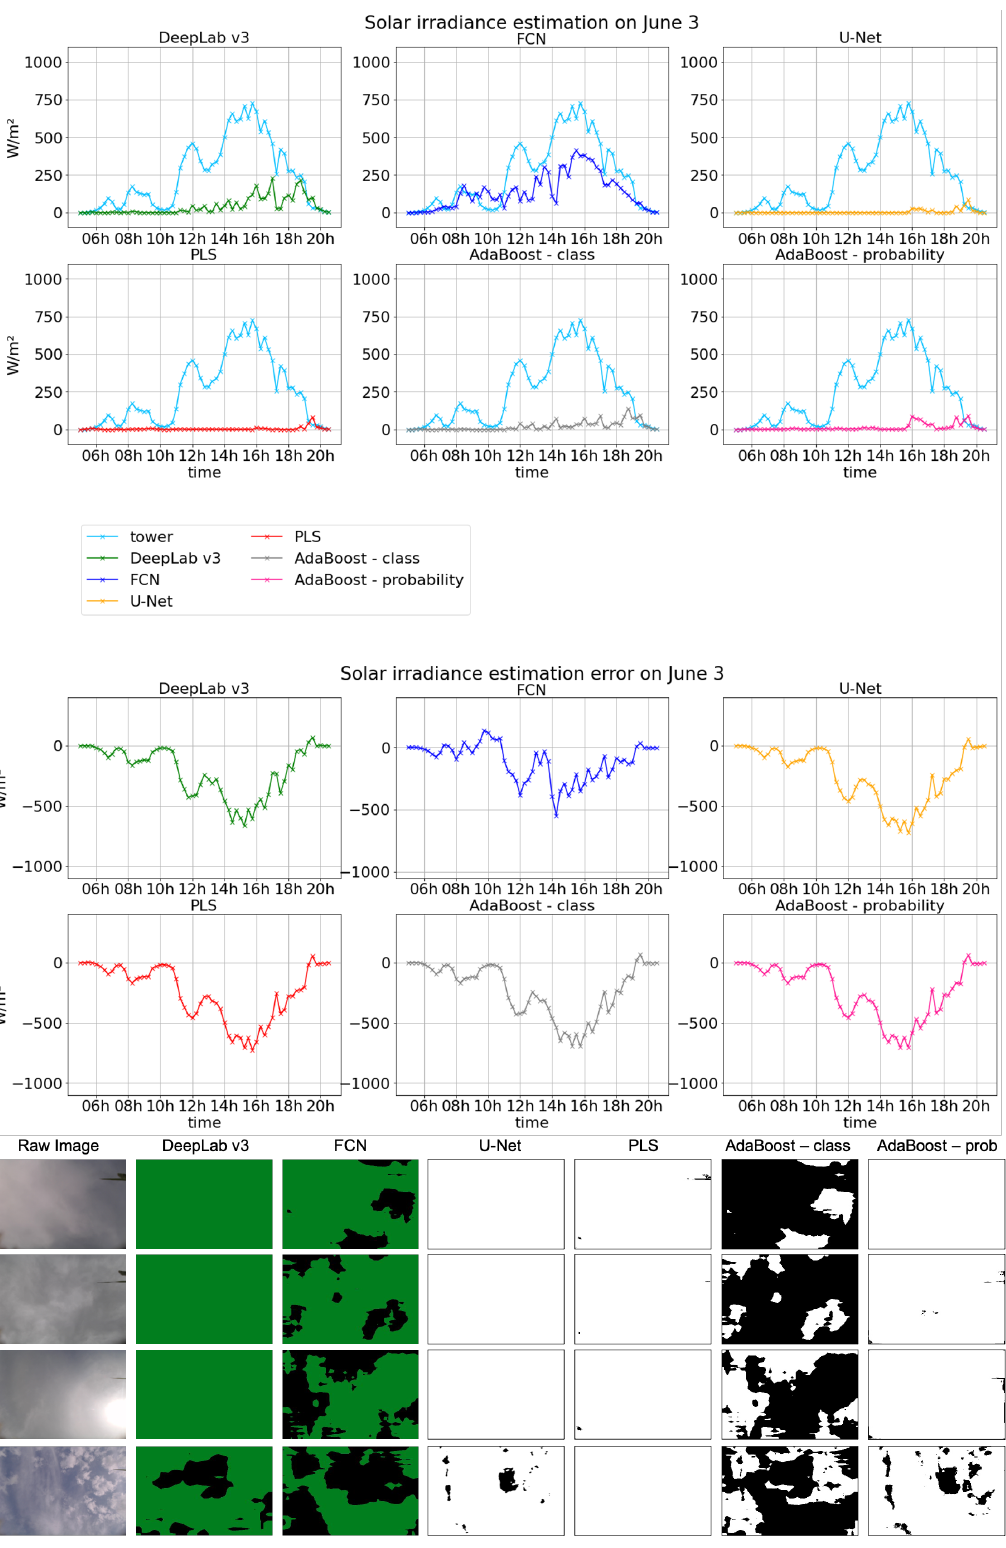
Figure A7. Solar irradiance estimation result based on cloud cover estimation from each machine learning model